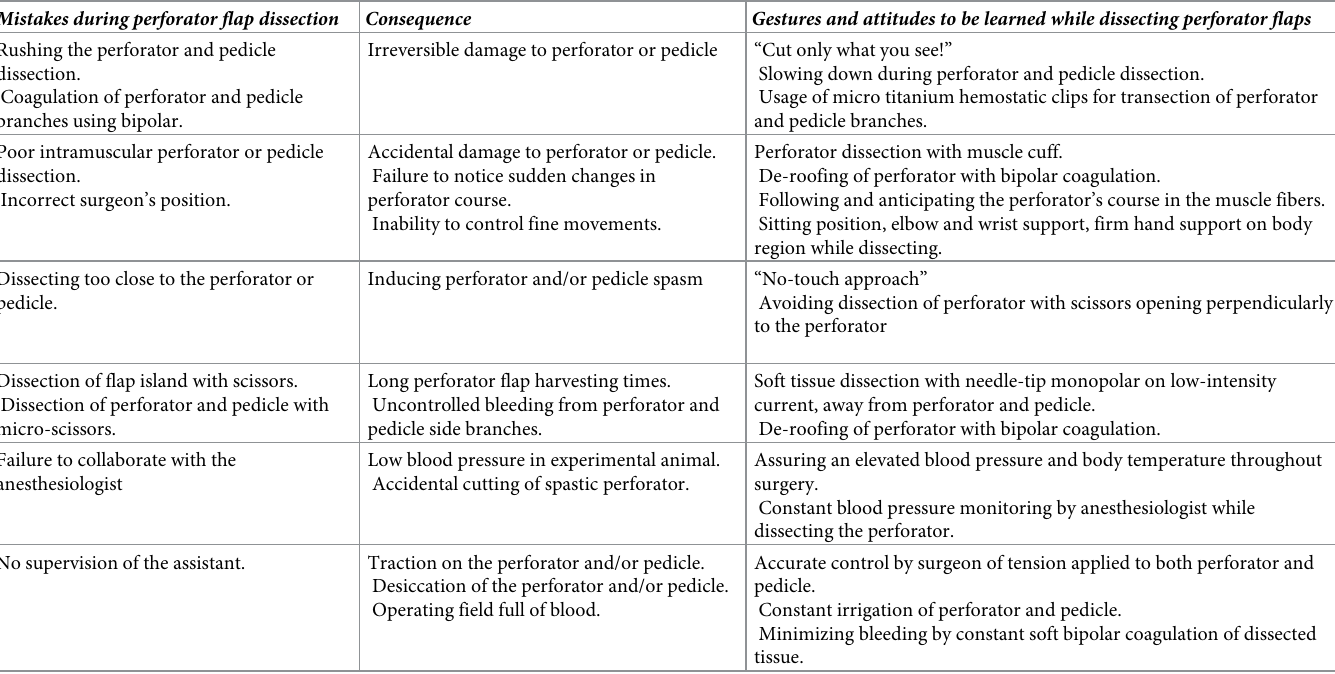
Table 2. Skills to be trained using the pig perforator flap